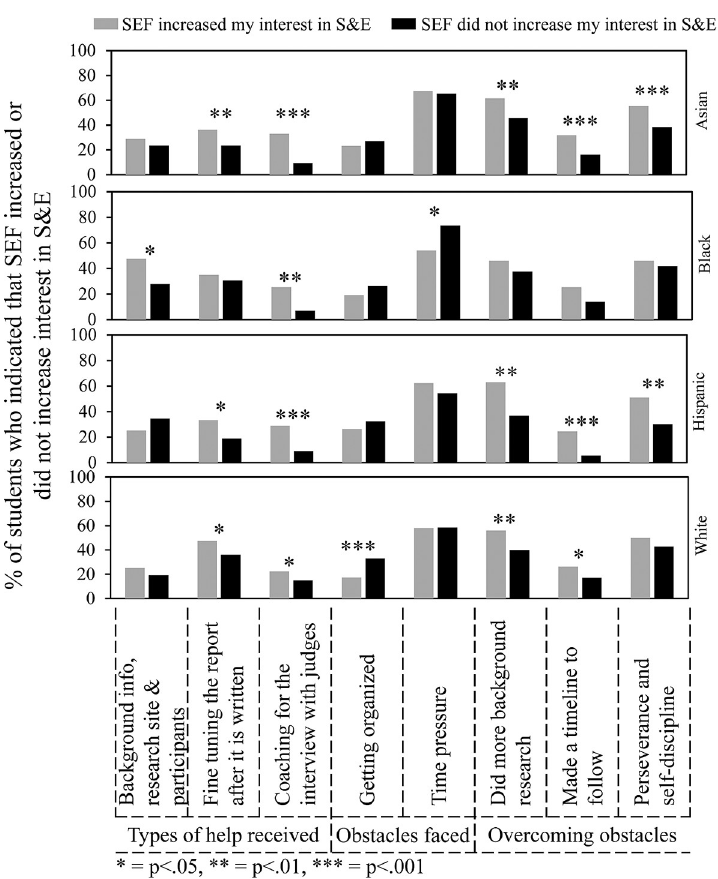
Fig 10. Kinds of help, obstacles faced, and ways to overcome obstacles that influenced impact of SEF on student interest in S&E.